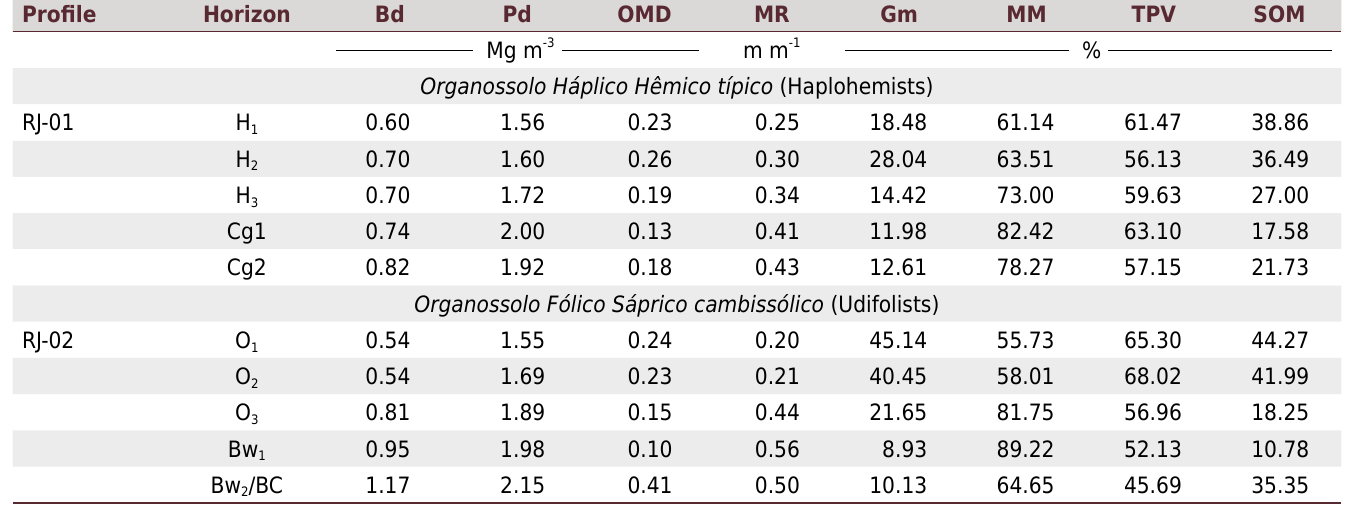
Table 3. Soil bulk density (Bd), particle density (Pd), Organic matter density (OMD), minimum residue (MR), gravimetric moisture (Gm), mineral material (MM), total pore volume (TPV), and soil organic matter (SOM) of Organossolos of Itatiaia National Park, Rio de Janeiro, Brazil